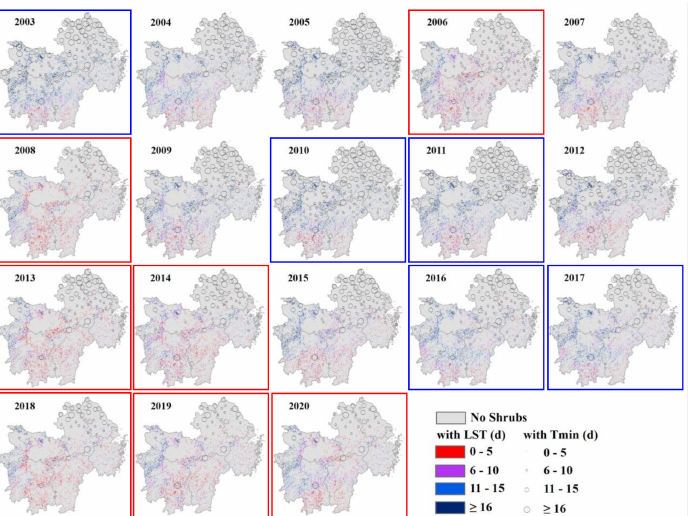
Figure 8. Spatial characteristics of annual SFD days for tea plants in 2003–2020 in the middle and lower reaches of the Yangtze River region, China. Pixels with different colors and different size circles were the SFD days calculated from satellite-based estimates of land surface temperature (LST) and with ground-based minimum temperature (Tmin) observations, respectively. Blue frames around panels indicate years with large areas covered by more SFD days, red frames around panels indicate years with large areas covered by fewer SFD days, and no frames indicate years with nearly even areas covered by more SFD days and fewer SFD